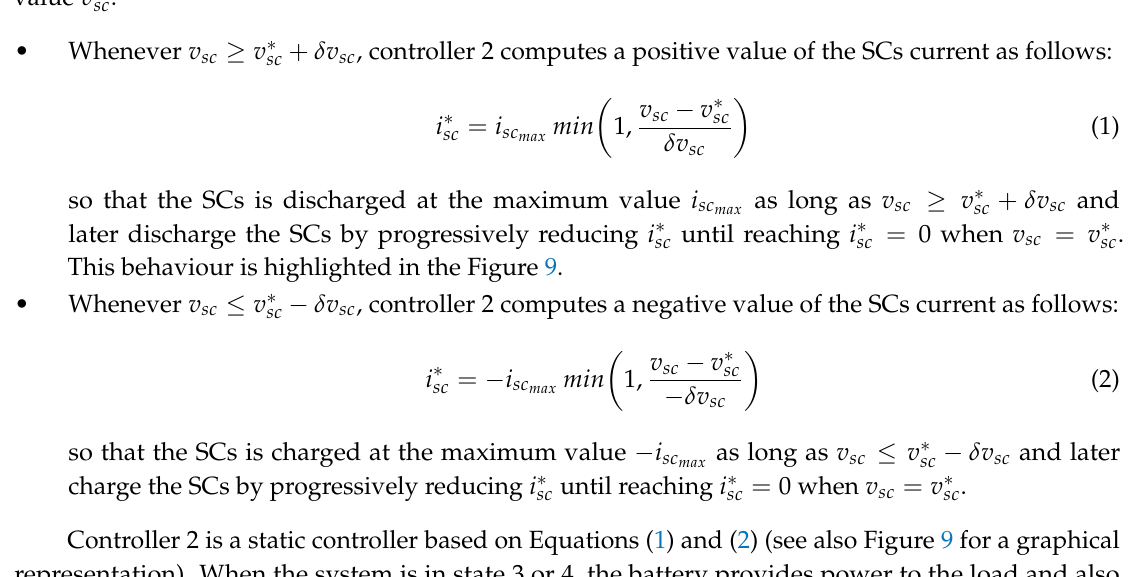
) according the SCs voltage for controller 1. max